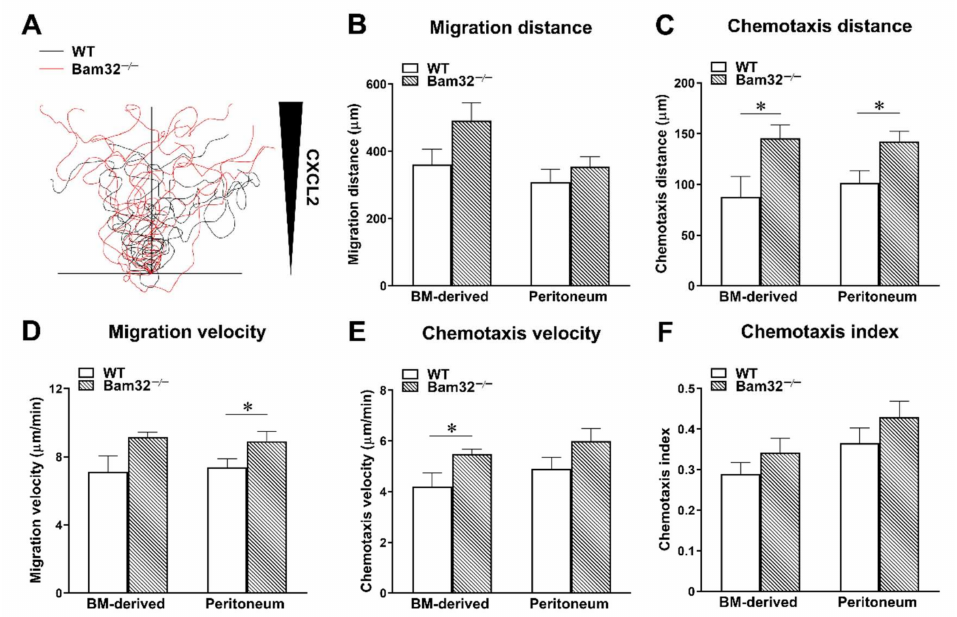
Figure 3. Effect of Bam32 deficiency on CXCL2-induced chemotaxis of bone marrow-derived neu- trophils and pre-stimulated peritoneum neutrophils in vitro. Spider plots ( A ) display the chemotactic paths of representative 10 individual neutrophils from one mouse of each strain. The migration distance in µ m ( B ), chemotaxis distance in µ m ( C ), migration velocity in µ m/min ( D ), chemotaxis velocity in µ m/min ( E ), and chemotaxis index of isolated neutrophils for 60 min in 2D chemotaxis µ -slide were quantified and averaged from >50 cells in each group ( F ). Mean ± SEM of 4 mice per group. * indicates significant difference ( p < 0.05) between WT and Bam32 − / − mouse strains. BM, bone marrow